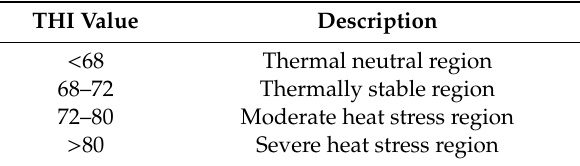
Table 1. The values of the temperature–humidity index (THI) used in the above